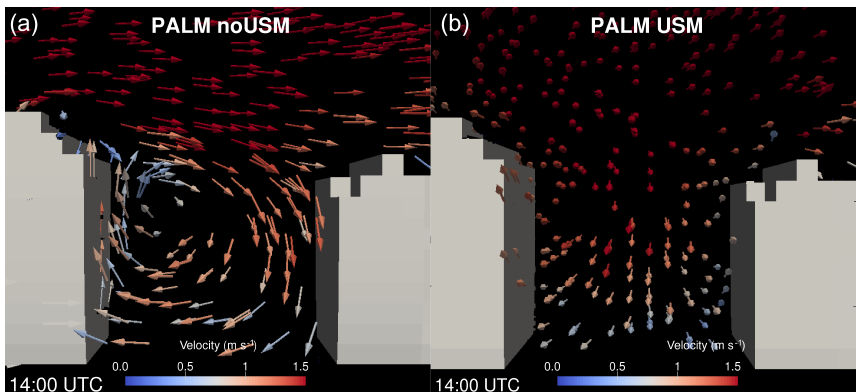
Figure 17. Wind field. Simulation without USM with prescribed surface heat fluxes (a) and with USM (b) . View from the southern border of the domain towards the crossroads.